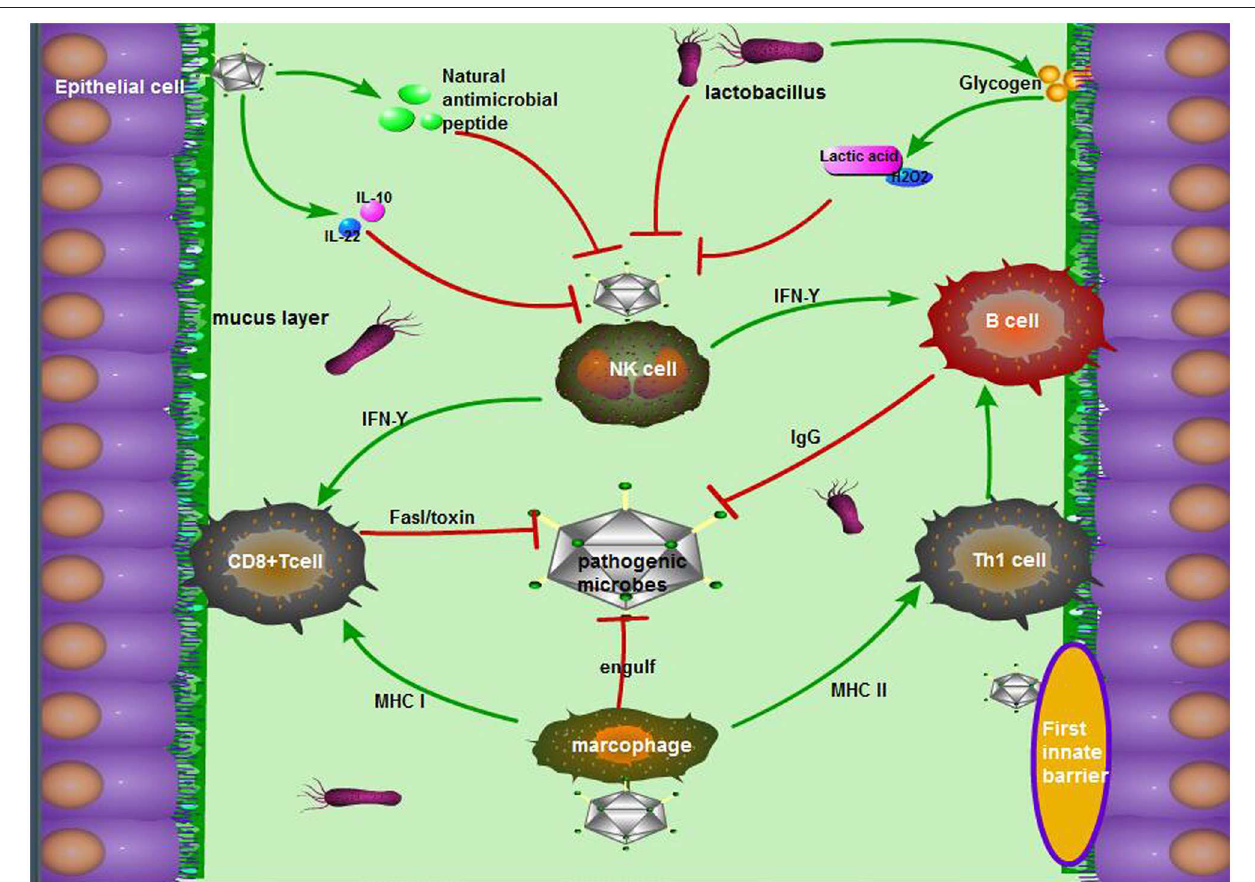
FIGURE 1 | The antimicrobial mechanism of the vagina during pregnancy. The mechanism mainly consists of the following three parts: (1) The first barriers: tight junctions of epithelial cells, movement of microvilli, and the package of mucus, as well as natural antimicrobial peptides from epithelial cells; (2) Exclusive effect of Lactobacillus on other pernicious biota: lactic acid, acidolin, lactacin, H 2 O 2 ; (3) The pathway including innate immune cells in the vagina, innate immune response, and acquired immune response. To be exact, antigen-derived cells, which make a sense by innate immunity, present pathogen antigens to acquired immune cells to kill, and crack